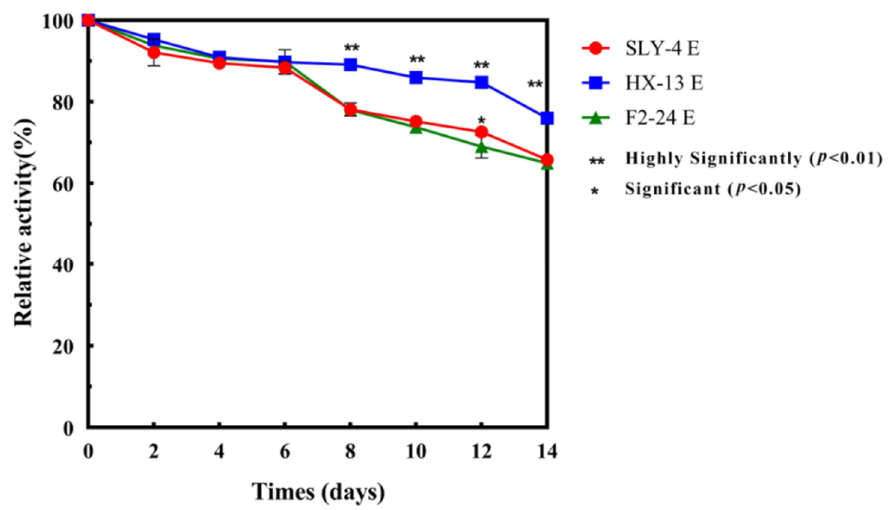
Figure 1. Stability of crude extracts of β -glucosidase in modified P-C